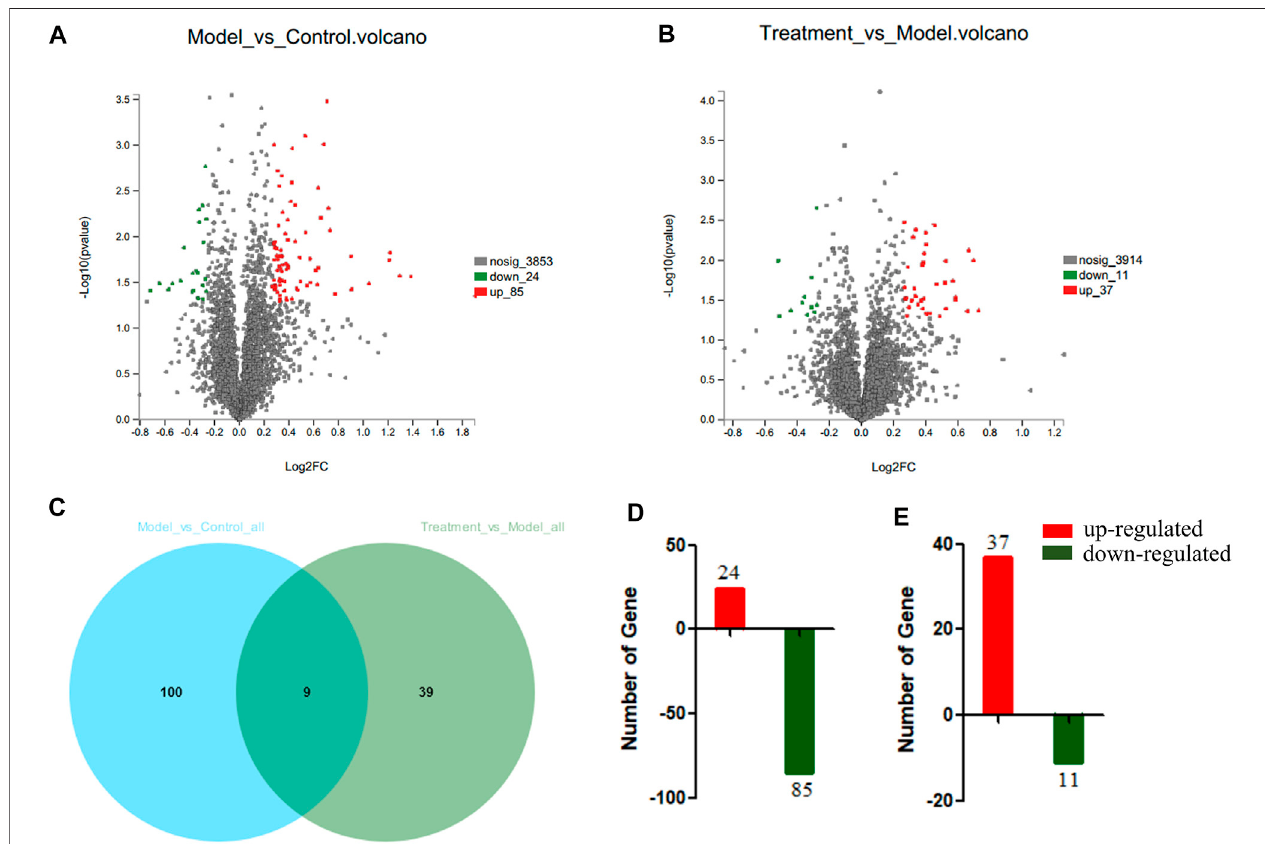
FIGURE 6 | The differentially abundant proteins (DEPs) in serum between Model:Control and Treatment: Model. (A) Volcano Plots of DEPs of Model:Control. (B) Volcano Plots of DEPs of Treatment:Model. (C) Venn-diagram showing the overlap of all DEPs. (D) DEPs involved in Model:Control. (E) DEPs involved in Treatment: Model. Red or Green represents the numbers of upregulated and downregulated proteins, respectively.